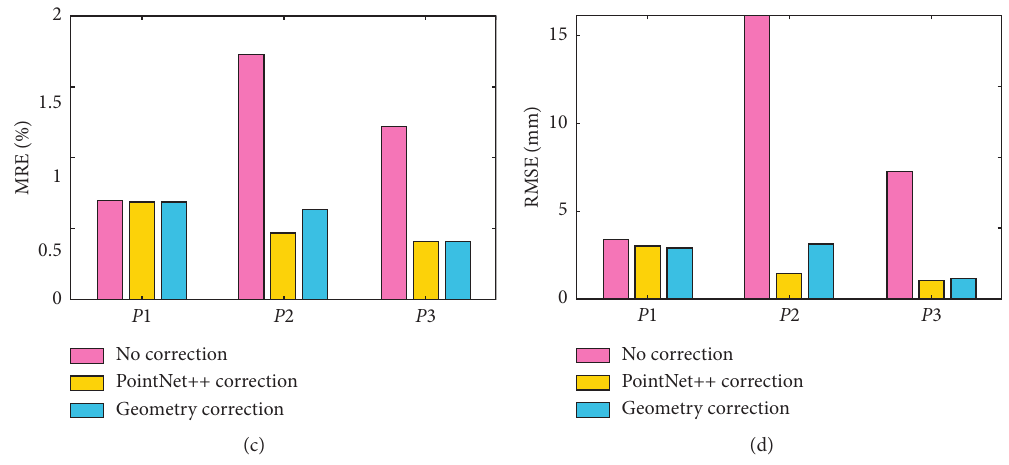
Figure 21: Critical indicators of vision measurement: (a) M ; (b) MAE; (c) MRE; (d)